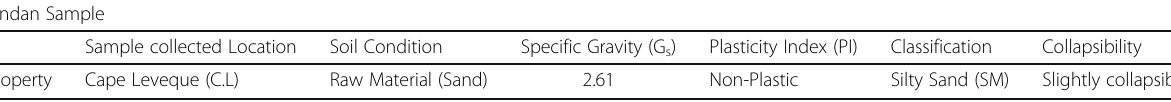
Table 4 Properties of Pindan soil grain used in Nanoindentation Pindan Sample Sample collected